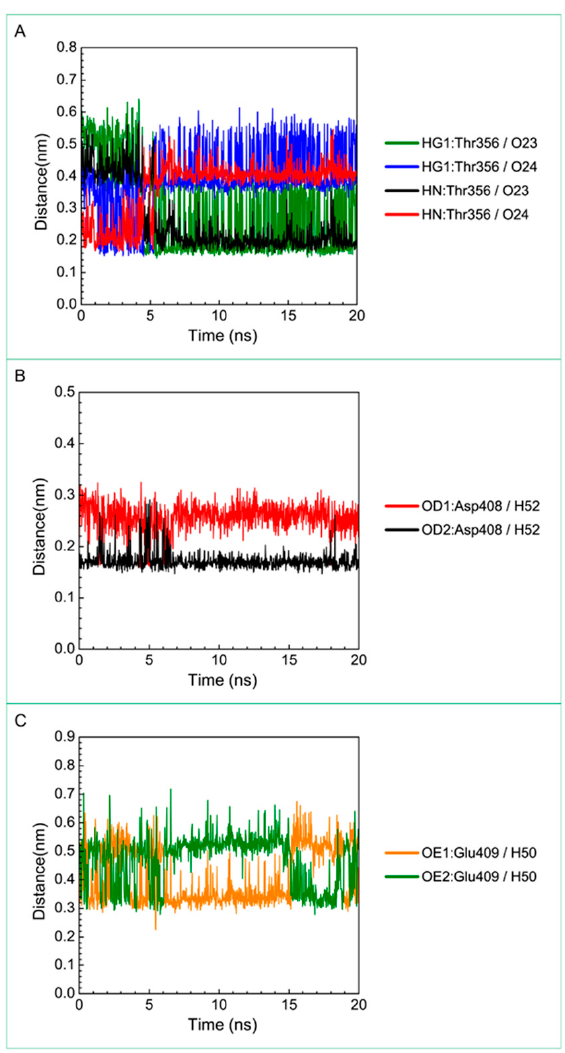
Figure 12. Distance variation of H-bonds for paraplegin complexes with saussureamine C during MD simulation. Display the distances between compound and amino acids ( A ) Thr356; ( B ) Asp408; and ( C ) Glu409.